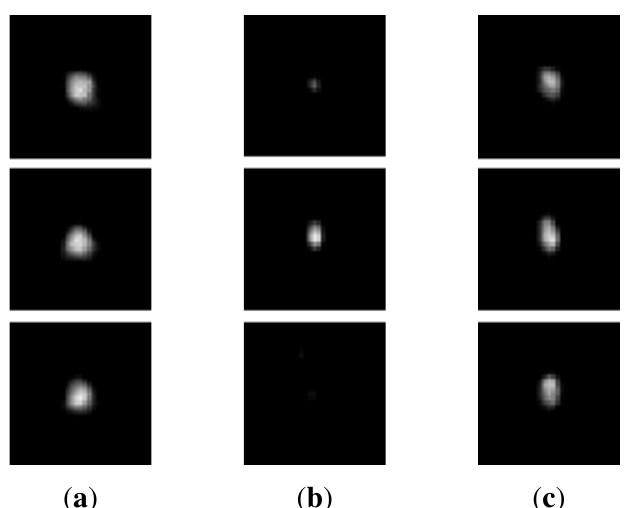
Figure 9. Rotation results of the three examples in Figure 8 based on the eigenvalues of the intensity distributions. ( a ) example 1; ( b ) example 2; ( c ) example